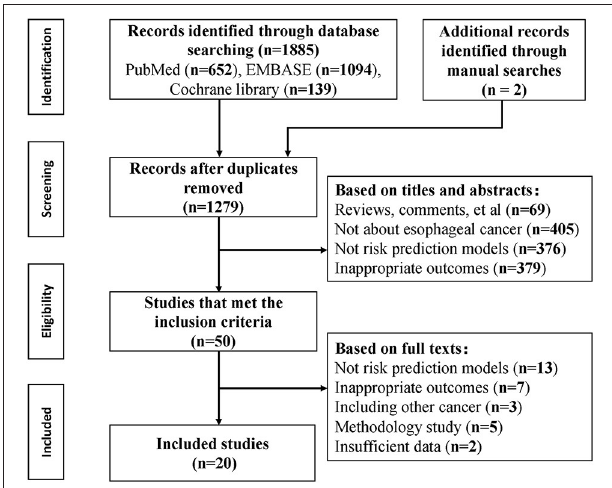
FIGURE 1 | Flowchart of literature search for risk prediction models of esophageal